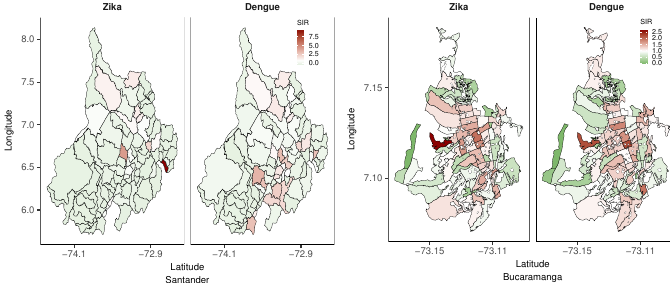
Figure 4. Accumulated standardized incidence ratio (SIR) maps of dengue and Zika virus disease (ZVD) in Santander and Bucaramanga from October 2015 to December